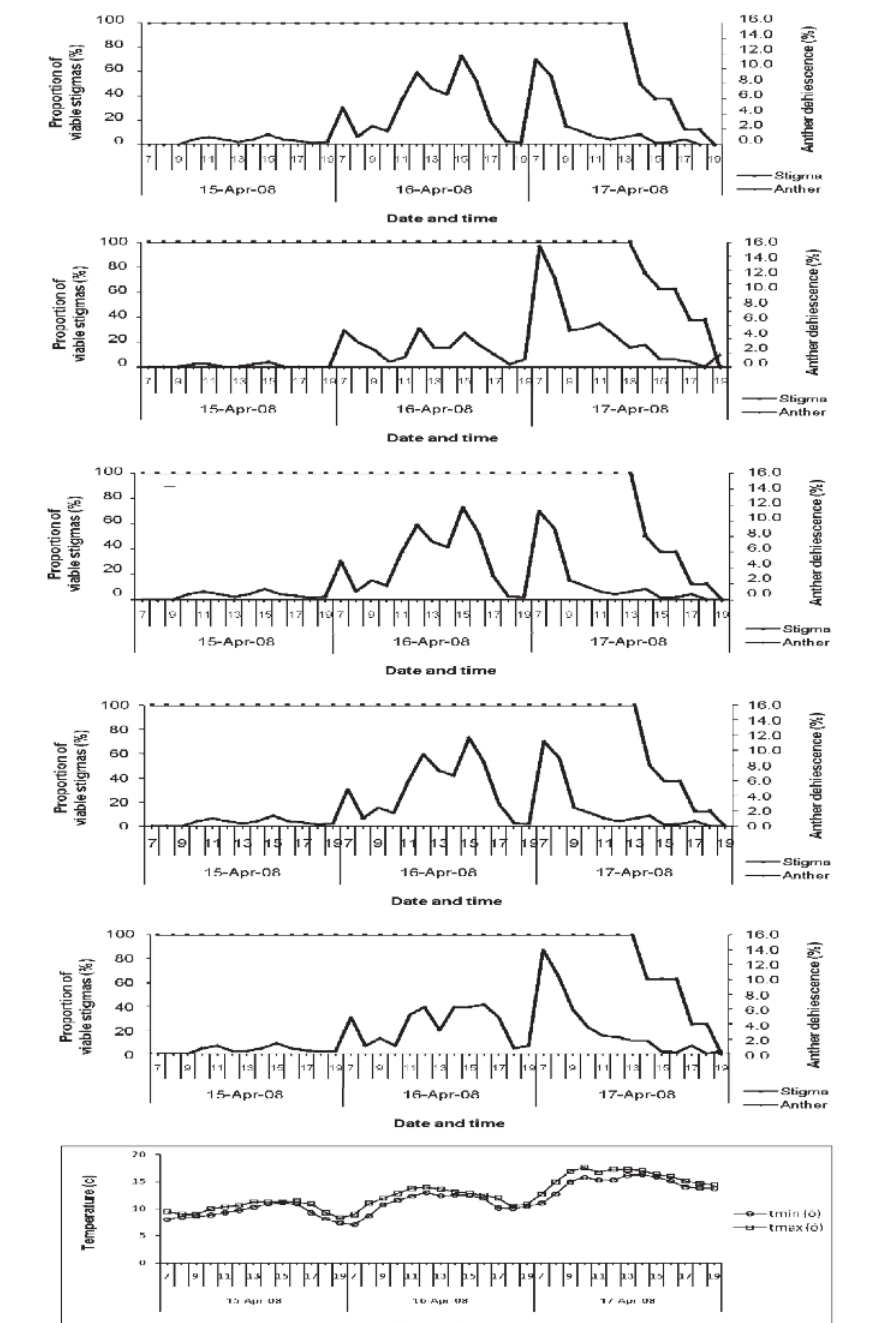
Figure 3. Reproductive organ activity of Hungarian sour cherry